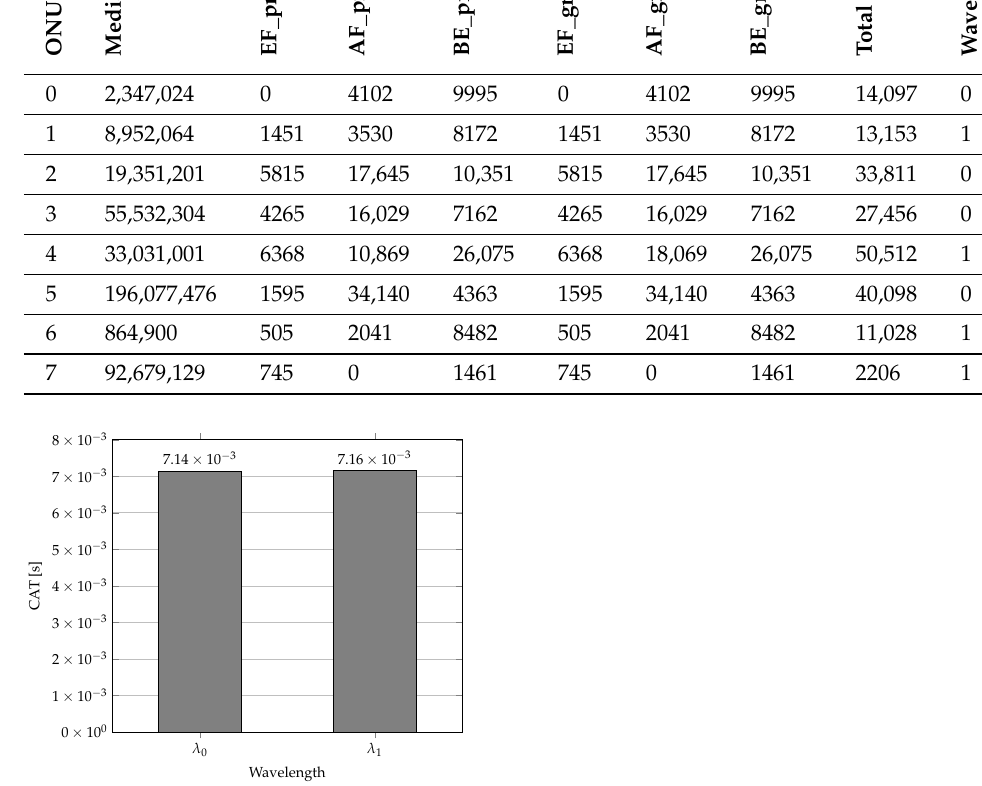
Figure 1. CAT parameter values in s for wavelengths in cycle No. 10 using Method